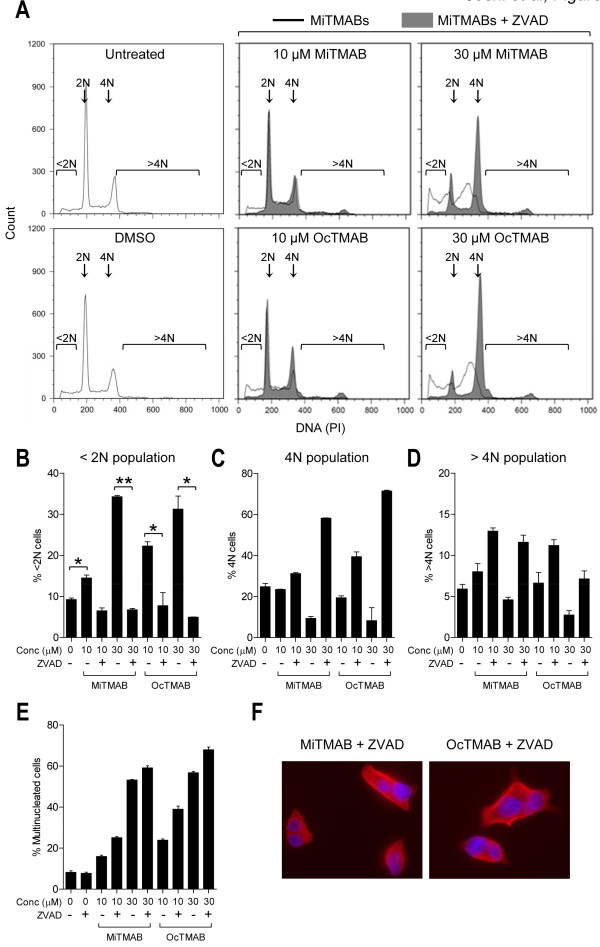
Cell death induced by MiTMABs is blocked by the pan-caspase inhibitor, ZVAD. A-D, G2/M synchronized HeLa cells were treated for 20 h with MiTMABs and controls (untreated, 0.1% DMSO and 2-(DiMA)EM) in the presence and absence of the pan-caspase inhibitor, ZVAD. DNA content in these cells was analysed by flow cytometry. Representative flow cytometry histograms of propidium iodide stained control treated (untreated and 0.1% DMSO) HeLa cells and HeLa cells treated with MiTMABs in the presence (filled histograms) and absence (empty histograms) of ZVAD are shown (A). The percentage of cells (mean ± S.D. from two independent experiments) with < 2N (DNA fragmentation, which is indicative of cells undergoing apoptosis; (B), 4N (C), and >4N (D) DNA content are shown. Treatment with MiTMABs + ZVAD caused a decline in cells containing <2N DNA and a corresponding increase in cells containing ≥ 4N DNA content compared to MiTMABs alone. * p < 0.05, ** p < 0.01 (Student's t tests). E, HeLa cells were treated as described in A except that after 8 h cells were fixed and stained for α-tubulin, and the percentage of cells that were multinucleated was scored using immunofluorescence microscopy. Graph shows mean ± S.D. from two independent experiments. F, Representative microscopy images of (E) illustrating multinucleated HeLa cells treated with either MiTMAB or OcTMAB in combination with ZVAD. Red, α-tubulin. DNA, blue.